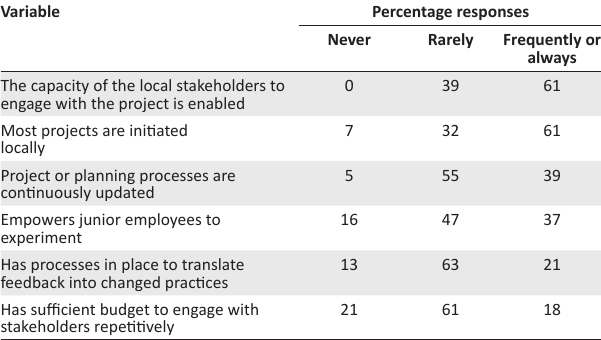
TABLE 3: Presence of organisational factors that contributed to learning.